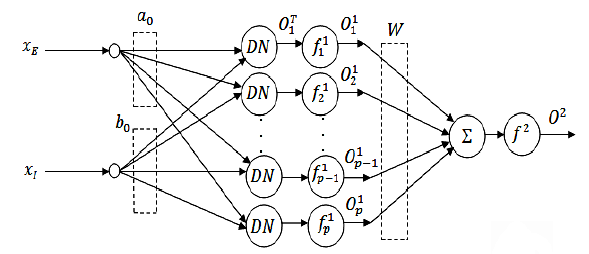
Figure 3. Modified dynamic neural network